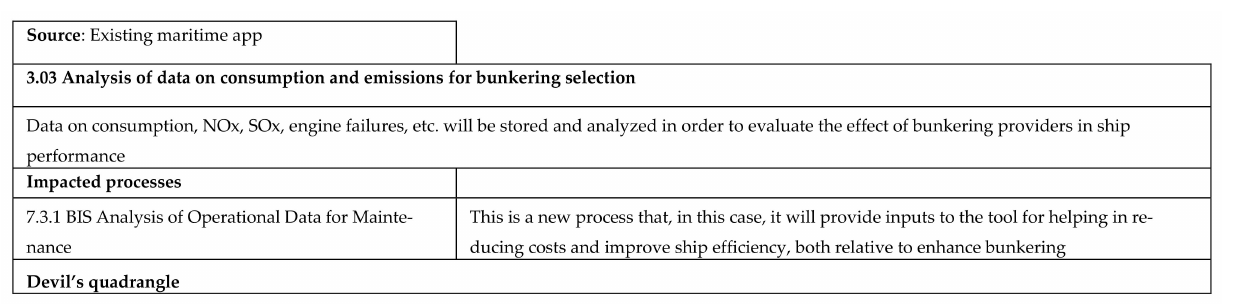
Figure A29. Cont